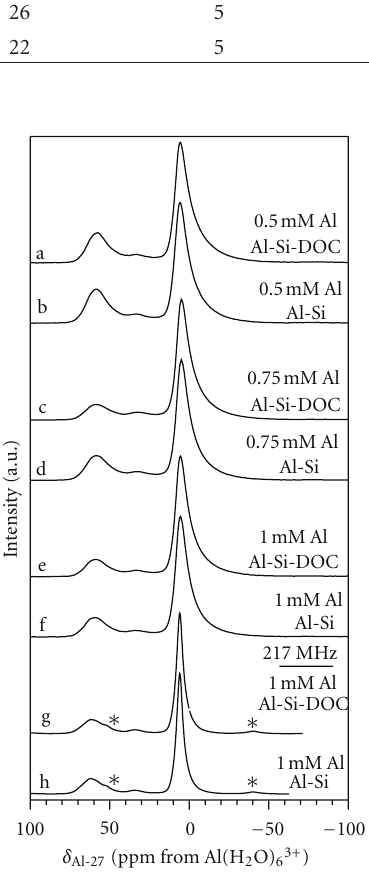
Figure 6: 27 Al MAS/NMR spectra of precipitates from solutions with 0.5mM Si and (a-b) 0.5 mM Al; (c-d) 0.75 mM Al; (e–h) 1.0mM Al; with and without 6 mg/L DOC as indicated. All spectra taken with SP excitation at 130.3 MHz (11.7 T) and 18kHz spinning rate, except (g-h) obtained at 217MHz (19.5 T), spinning at 10 kHz. Asterisks denote spinning